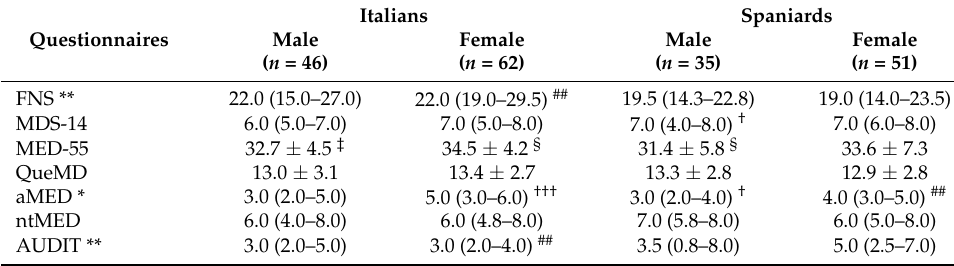
Table 5. Standardized questionnaires